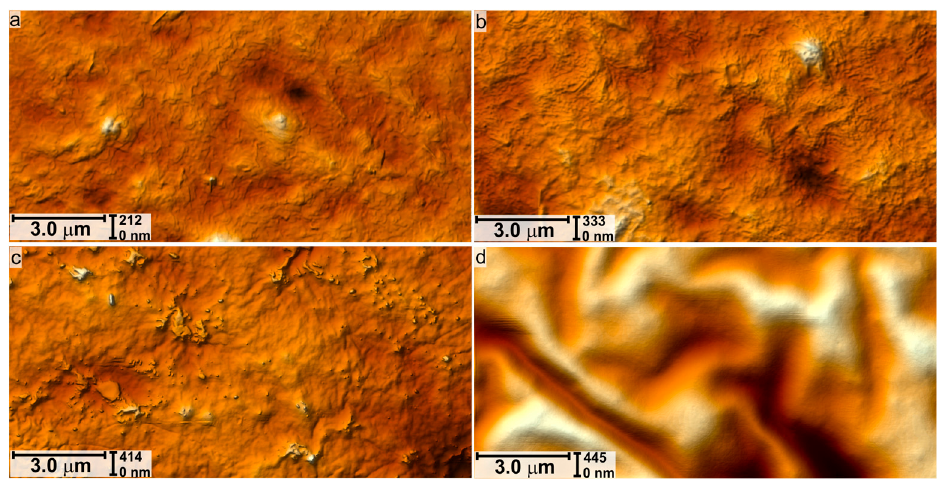
Figure 1. AFM images 15 × 7.5 μ m 2 of untreated ( a ) and treated with 1 keV, 2 × 10 16 ion/cm 2 ( b ); 1 keV, 2 × 10 17 ion/cm 2 ( c ); 1 keV, 3 × 10 17 ion/cm 2 ( d ) surfaces.